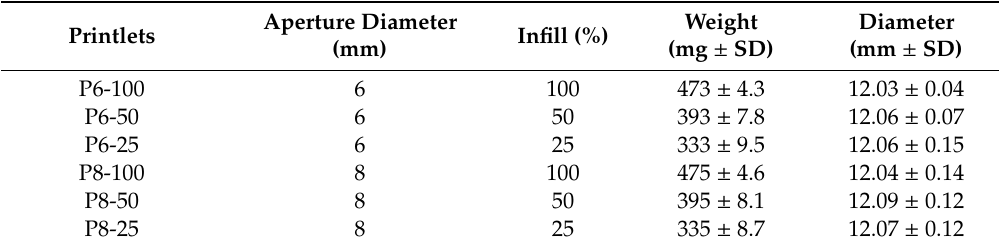
Table 3. Characteristics of the printlets.